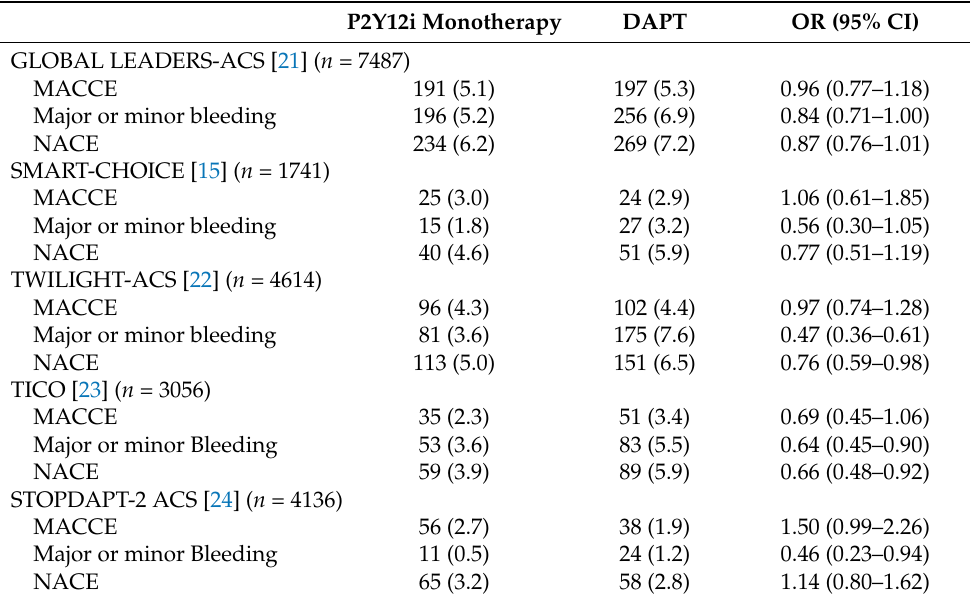
Table 2. The efficacy and safety outcomes of P2Y12 inhibitor monotherapy and DAPT in ACS patients of included